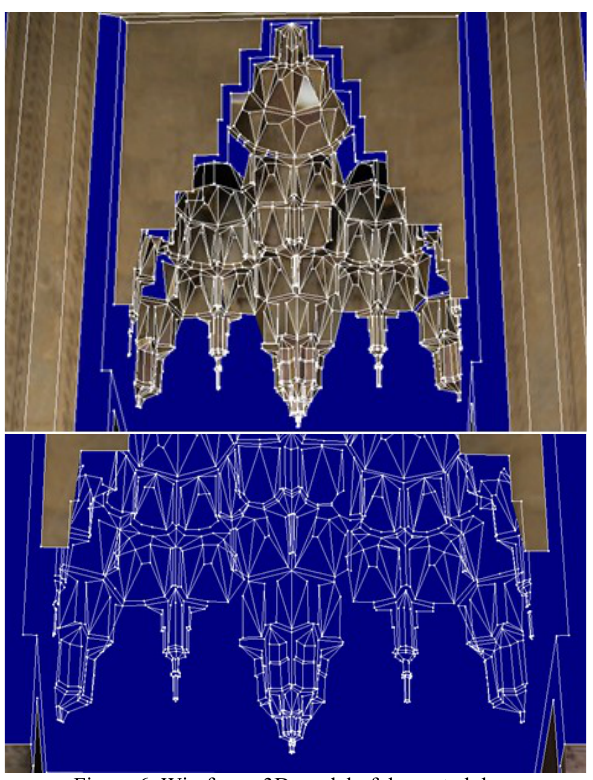
Figure 6. Wireframe 3D model of decorated door